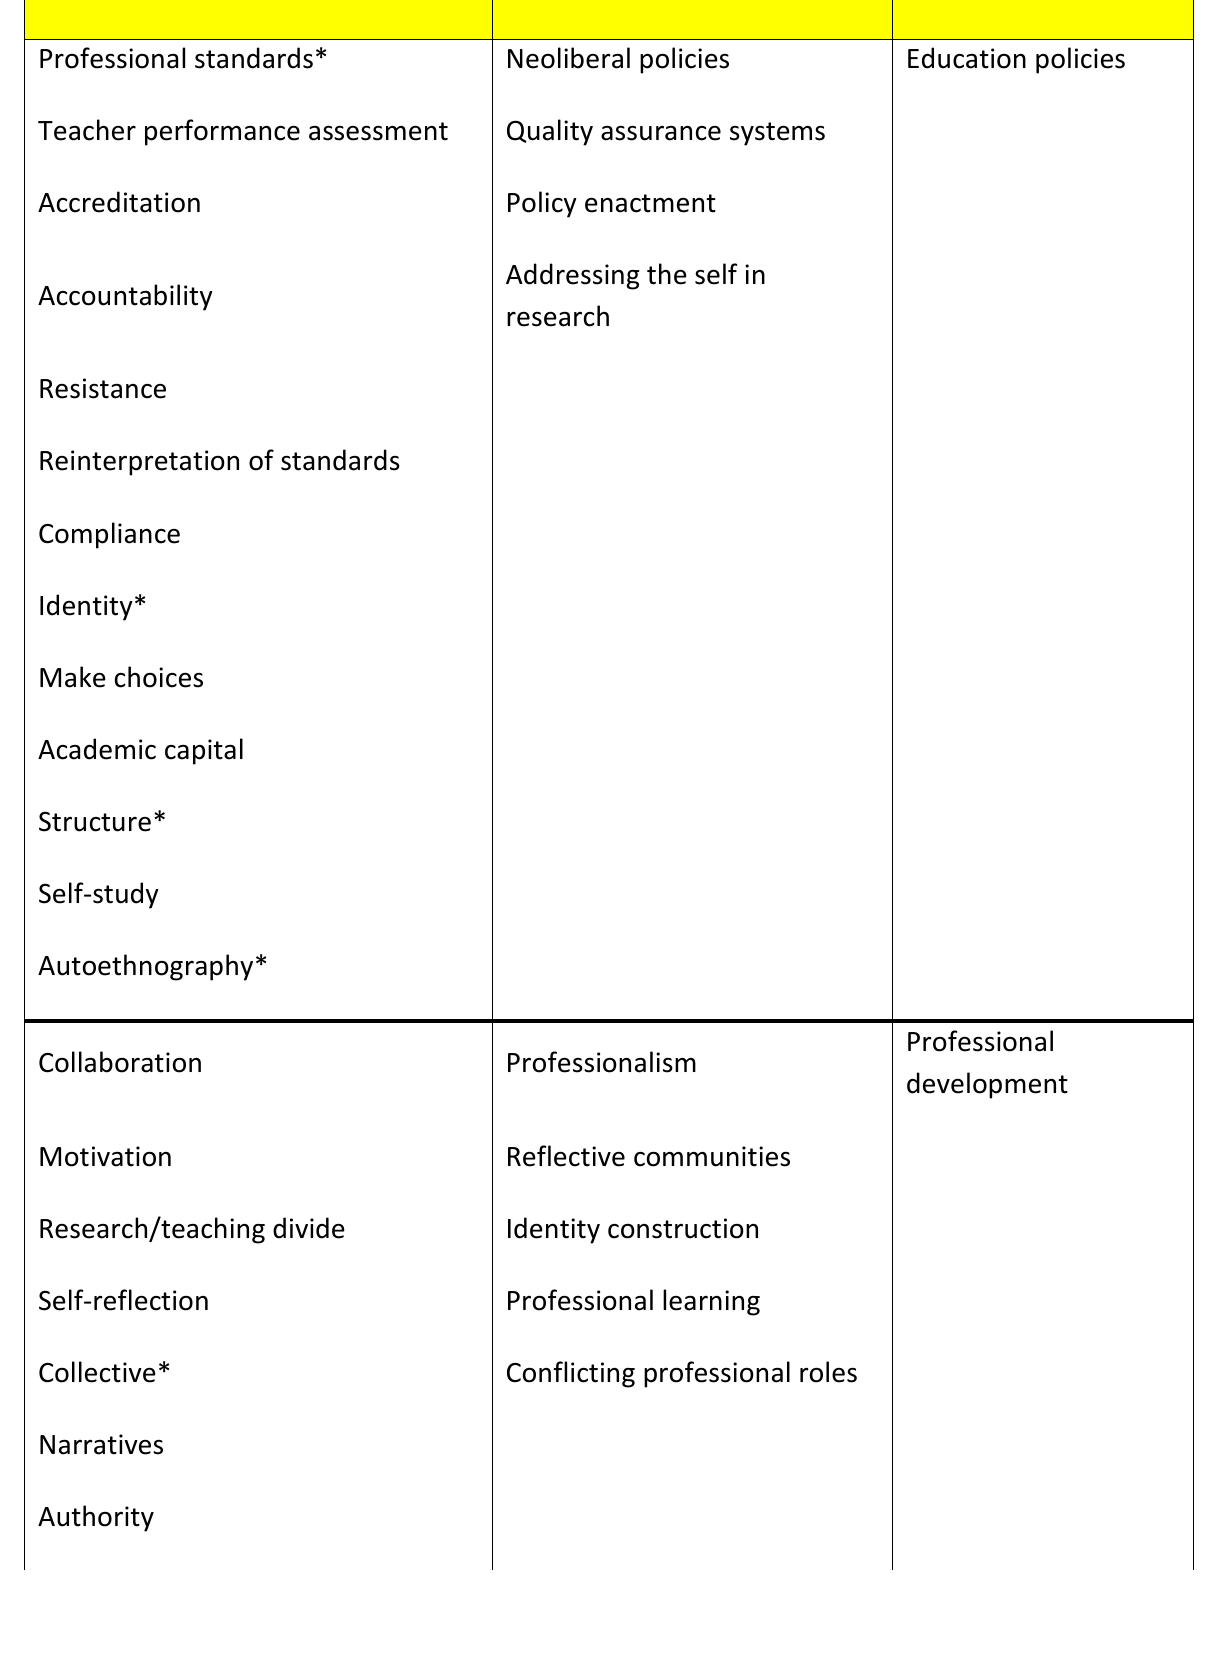
Table 2. Codes, sub-themes and emerging themes